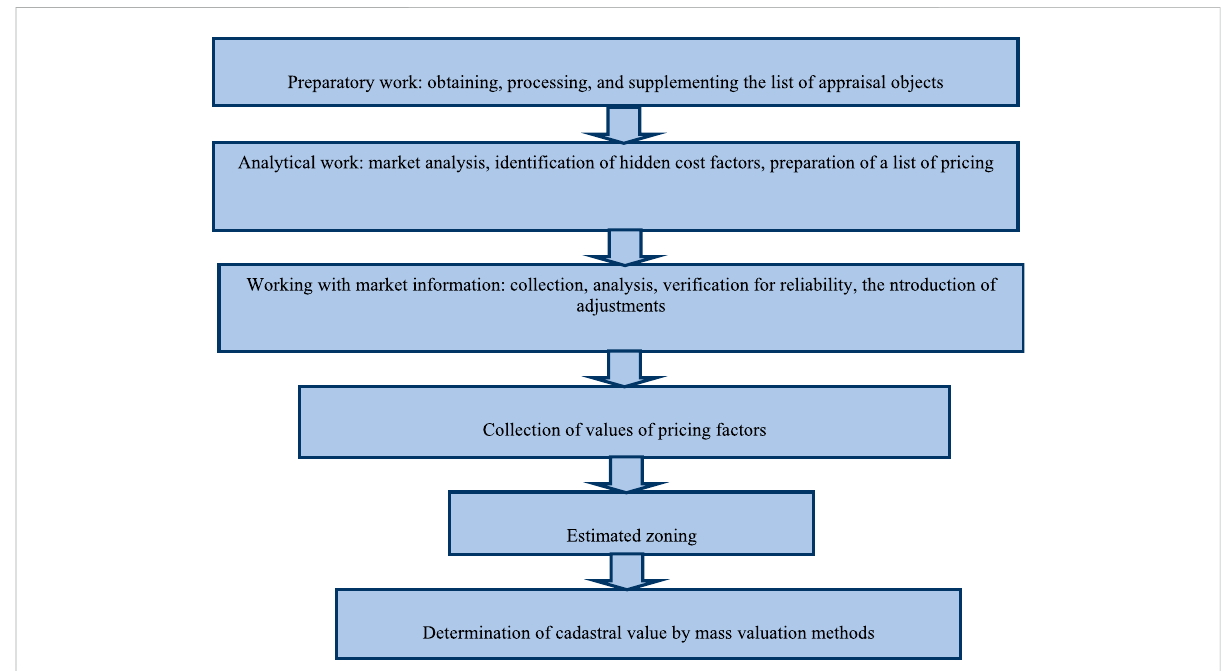
FIGURE 1 Technological scheme of the procedure for determining the cadastral value of land plots.